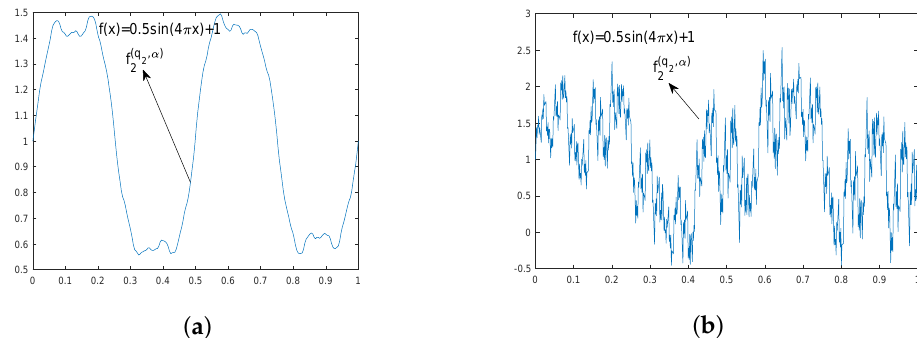
Figure 2. Positivity of MKZ fractal function according to Theorem 3. A positive quantum MKZ fractal function ( a ) and a non − positive quantum MKZ fractal function ( b